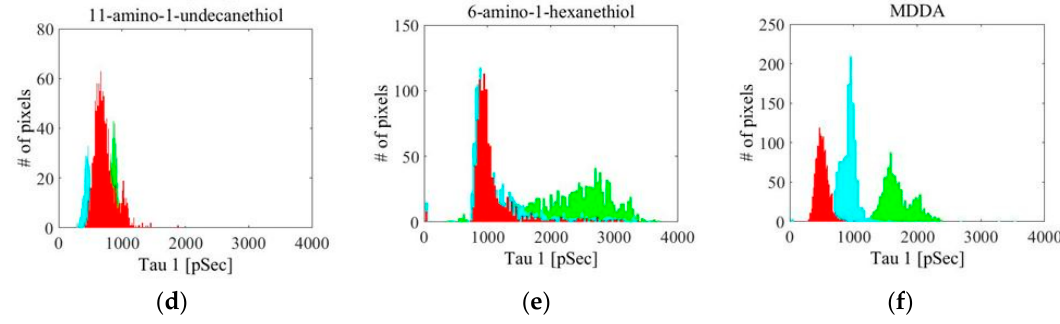
Figure 5. τ 1 histograms for fluorescein-conjugated GNR phantoms with different linkers: ( a ) NH 2 - PEG-SH-5 kDa; ( b ) NH 2 -PEG-SH-1 kDa; ( c ) 16-amino-1-hexadecanethiol; ( d ) 11-amino-1- undecanethiol; ( e ) 6-amino-1-hexanethiol; ( f ) MDDA. Histograms are shown for three areas indicated by the different colors. In all phantoms, Au concentration was 0.05 mg/mL, and fluorescein concentration was 0.33